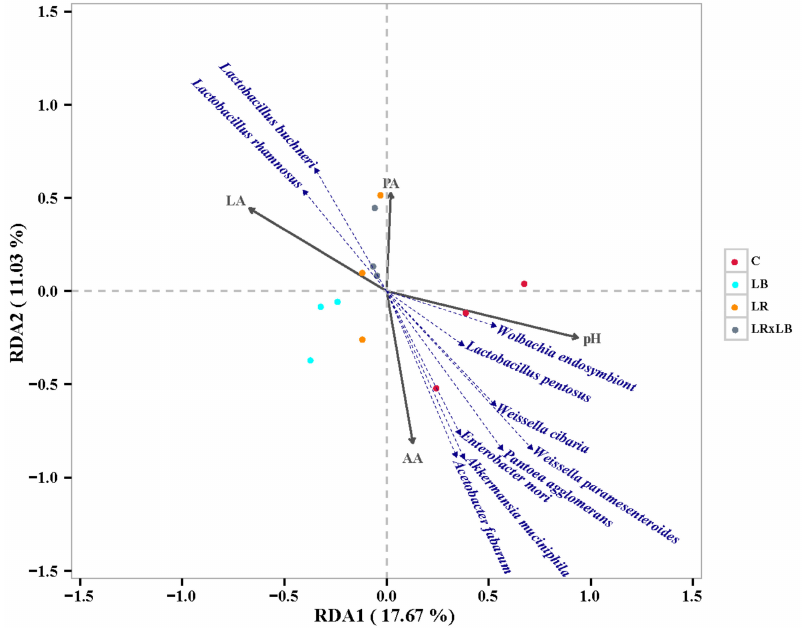
Figure 3. Redundancy analysis between fermentation characteristics and microbial community. C: silage with distilled water; LB: silage with LB-TSy; LR: silage with LR-BDy; LR × LB: silage with LB-TSy and